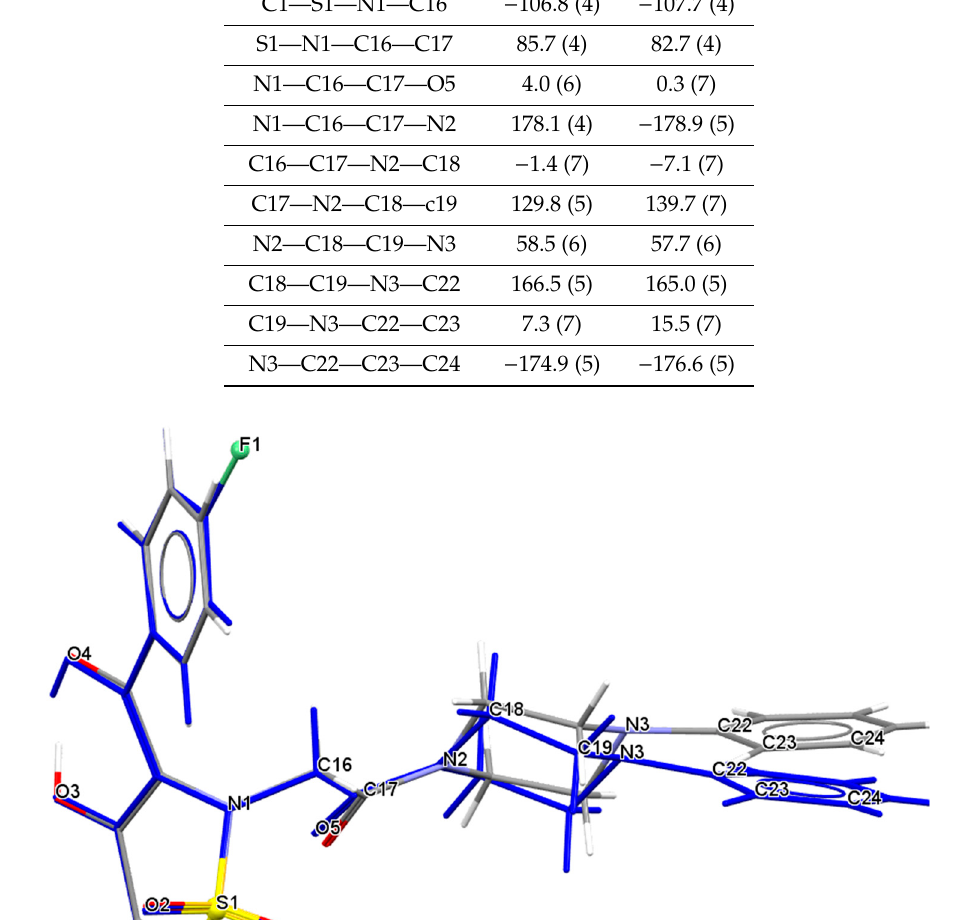
Table 2. Comparison of the selected X-ray conformational parameters (Å, ◦ ) for 7i and 7a .